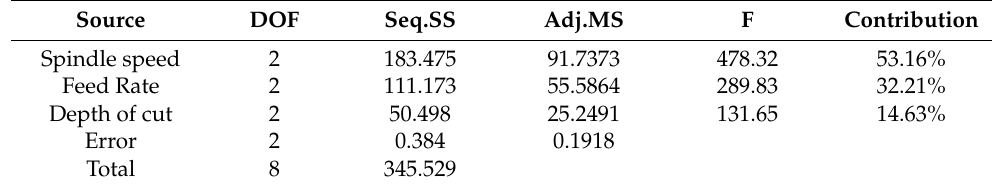
Table 5. ANOVA analysis for cutting force of 4 ◦ PCD tool.